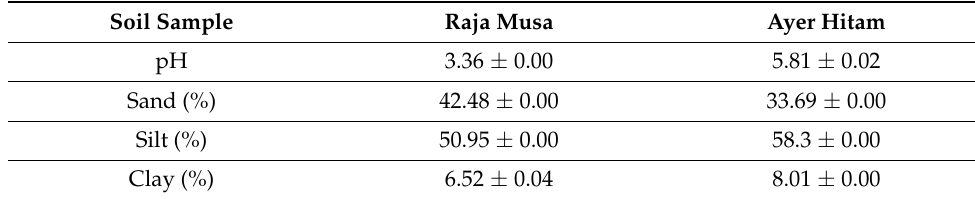
Table 1. The means value of physical properties for RMFR and AHFR soil